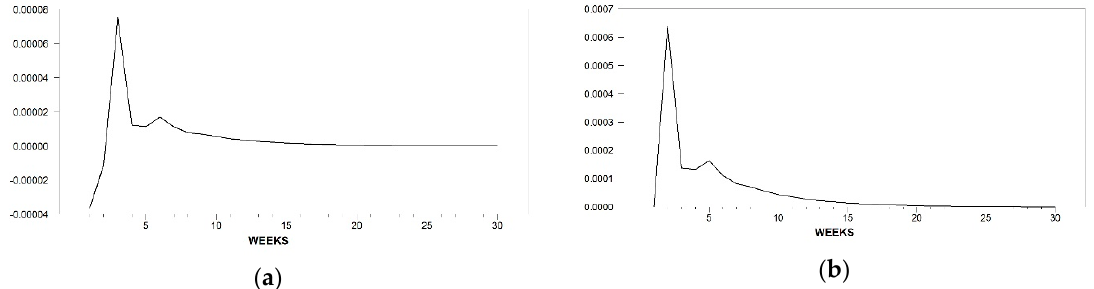
Figure 2. IRF for PDO Parmigiano Reggiano cheese. ( a ) Response of retail price to a shock in farm price; ( b ) Response of farm price to a shock in retail price.